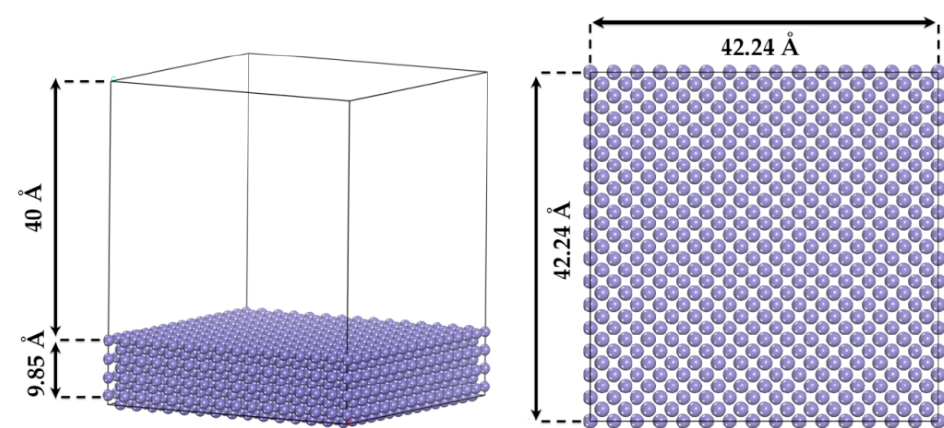
Figure 2. Side-view of the periodic slab for the Fe (100) metal surface used in Monte Carlo simulations.